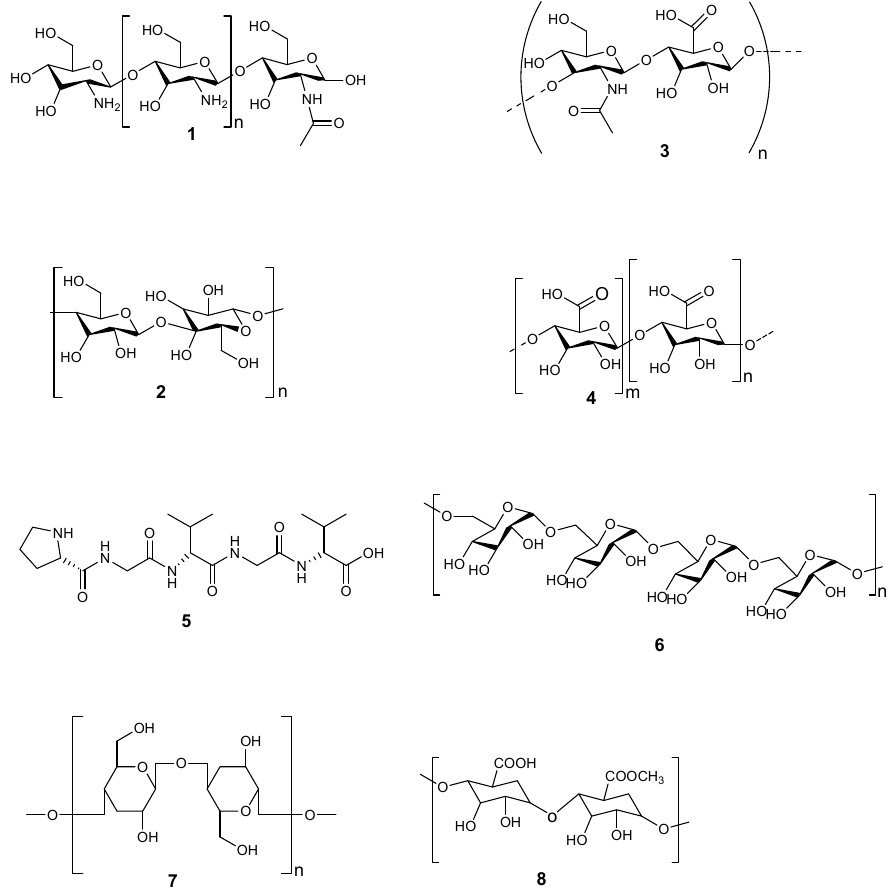
Figure 3. Molecular structures of biopolymers: chitosan 1, cellulose 2, hyaluronic acid 3, alginate 4, Elastin 5, dextran 6, fibrin 7, pectin 8.